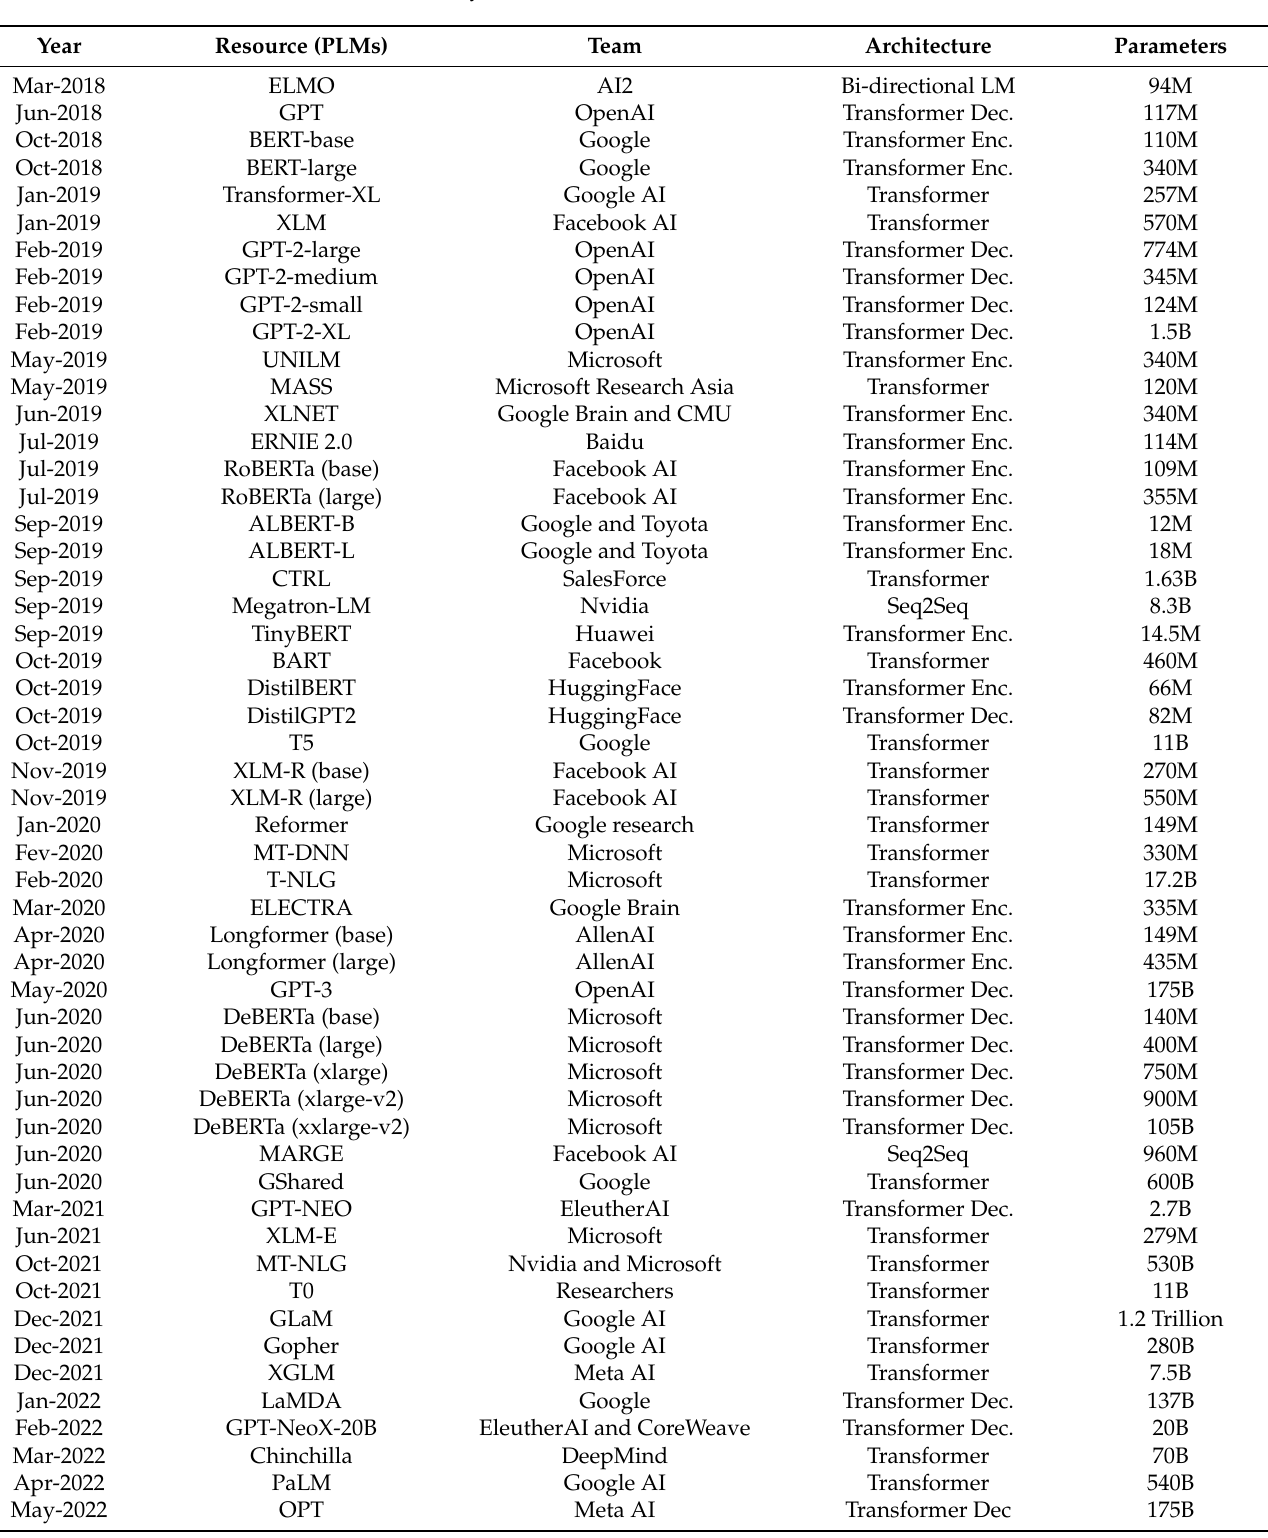
Table 3. Summary of recent